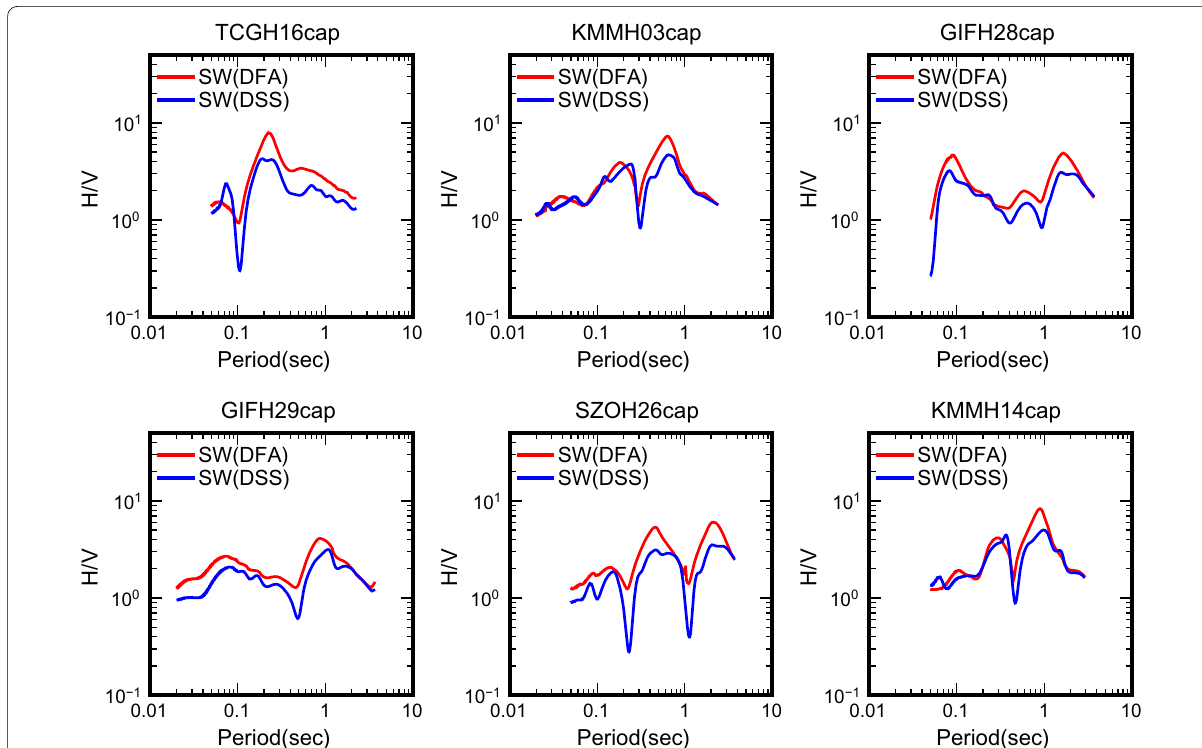
Fig. 9 DFA‑SW (red) and DSS‑SW (blue) H / V s of cap‑layered media at six KiK‑net strong‑motion stations. The underground velocity structures from surface to cap layer are used to evaluate DFA‑SW and DSS‑SW H / V s. Smoothing (Konno and Ohmachi 1998) is applied on DSS‑SW H / V s, but not DFA‑SW H / V which is already